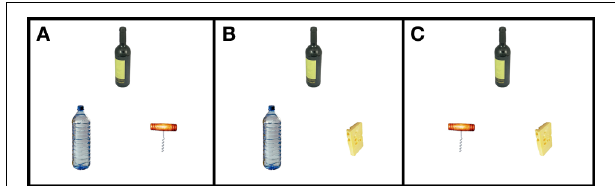
FIGURE 1 | An example of the three different triad types for one of the reference objects (wine bottle) presented during testing: (A) Th + A vs. Tax (corkscrew, water bottle), (B) Th-A vs. Tax (cheese, water bottle), and (C) Th-A vs. Th + A (cheese, corkscrew). The reference object was always positioned at the top and the two possible choices at the bottom of the triad. Each object was coarsely scaled to retain a realistic analogy to the other objects in the